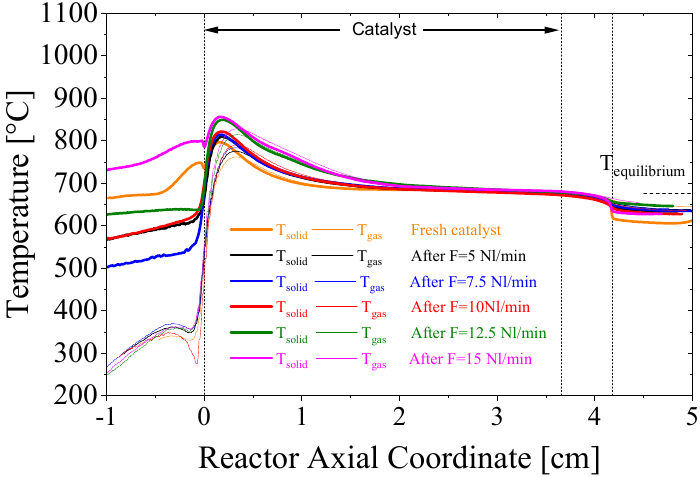
Figure 7. E ff ect of flow rate variation on the catalyst stability. CH 4 = 27.3%, air with C / O = 0.9,